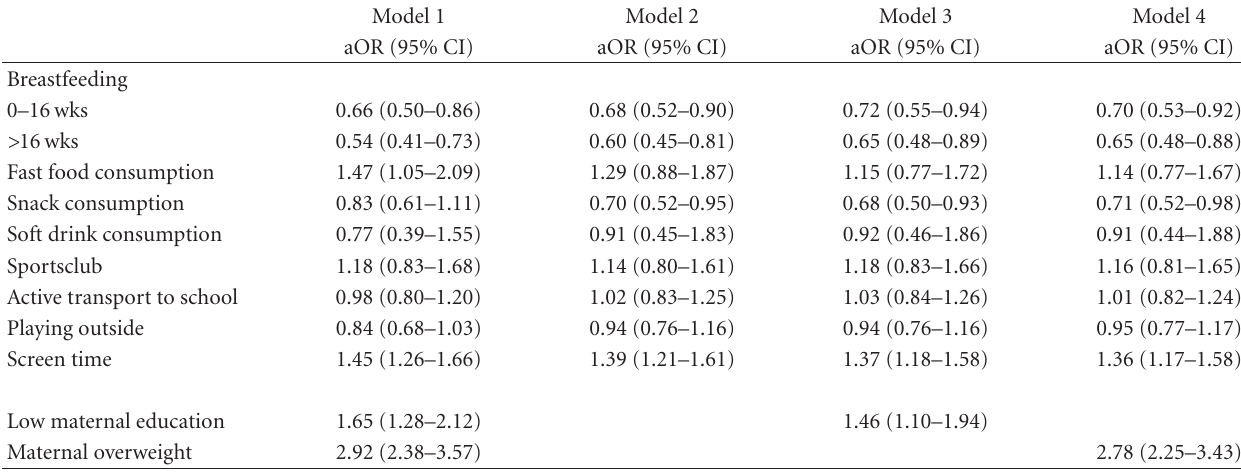
Table 2: Adjusted odds ratios (95% CI) for the associations of behavioral risk factors, low maternal education, and maternal overweight with overweight (including obesity) at the age of 8